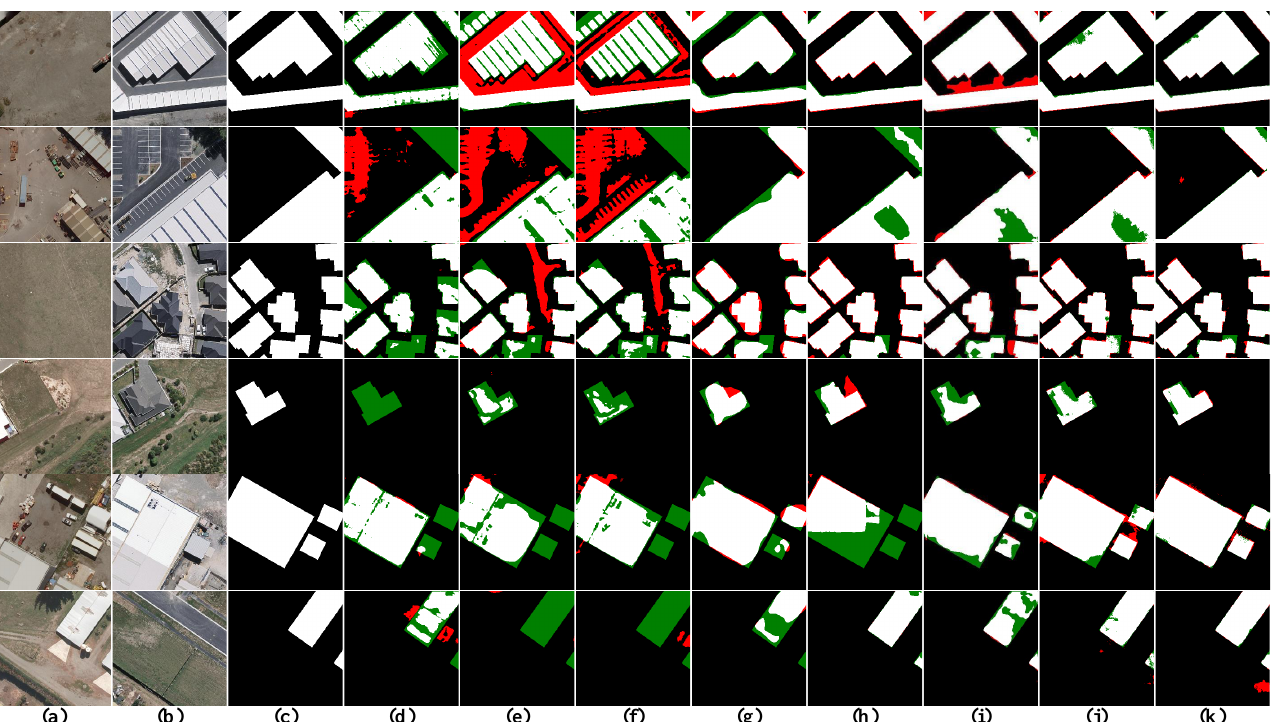
Figure 9. Visualization results on the BCDD dataset. ( a ) T1 images. ( b ) T2 images. ( c ) Ground Truth. White indicates correctly detected changed areas, black indicates correctly detected unchanged areas, red indicates incorrectly detected unchanged areas as changed areas, and green indicates unpredicted changed